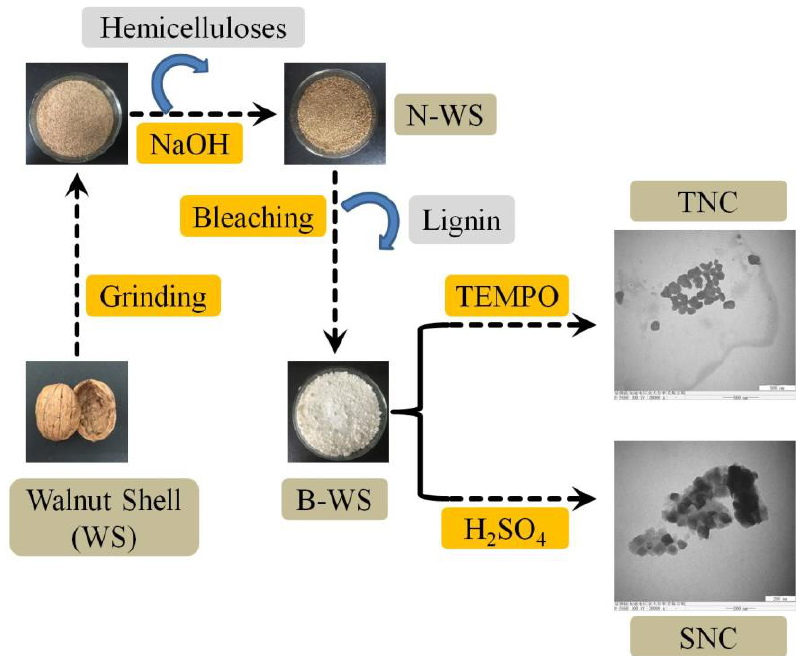
Figure 1. Procedure used to isolate nanocellulose from the walnut shell.